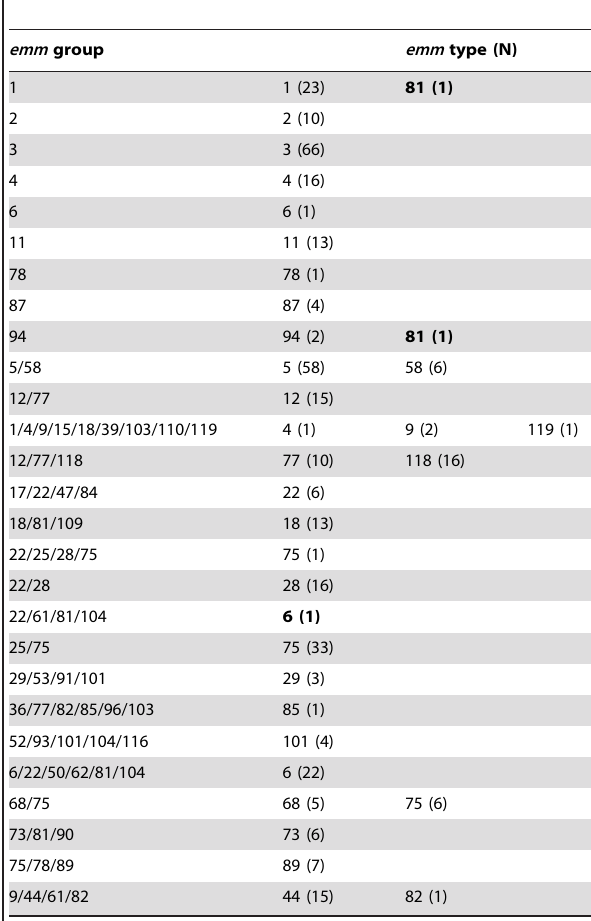
Table 1. Correlations between emm groups and emm